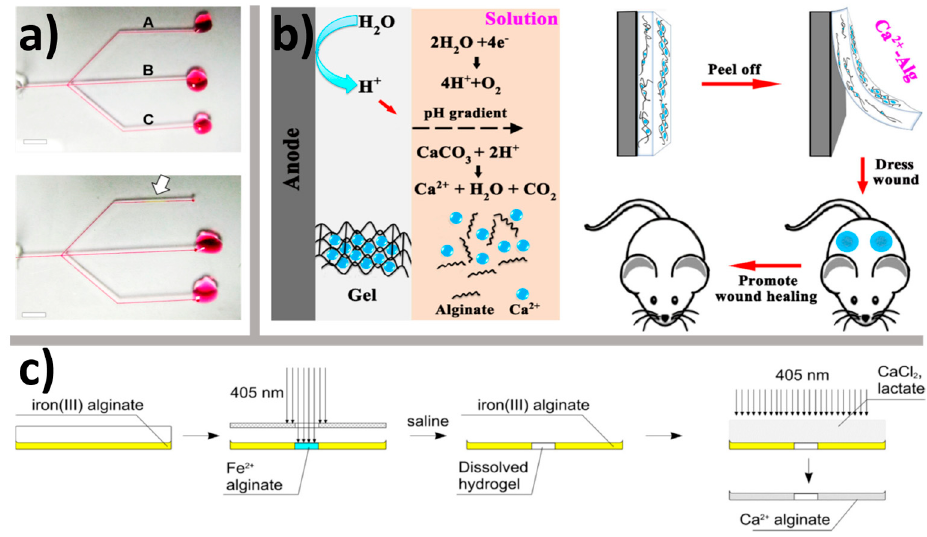
Figure 5. ( a ) localized flow-blocking by UV induced gelation of alginate; upper panel: the fluid flows freely through all three channels (A, B and C); lower panel: gel is formed (indicated by arrow) in the channel A upon UV exposure; ( b ) electrodeposition of calcium-crosslinked alginate film triggered by the release of Ca 2+ ions from insoluble CaCO 3 particles; ( c ) preparation of patterned calcium crosslinked alginate hydrogel by photochemical patterning of iron (III) crosslinked alginate hydrogel, dissolution of the exposed areas and photochemical reductive cation exchange. See text for details. Part ( a ) is adapted with permission from Oh et al. [49], Copyright (2016), American Chemical Society; part ( b ) is reproduced by permission from Liu et al. [50], Copyright (2017), Springer Nature; part ( c ) is adapted from Bruchet and Melman [51], Copyright (2015), with permission from Elsevier.